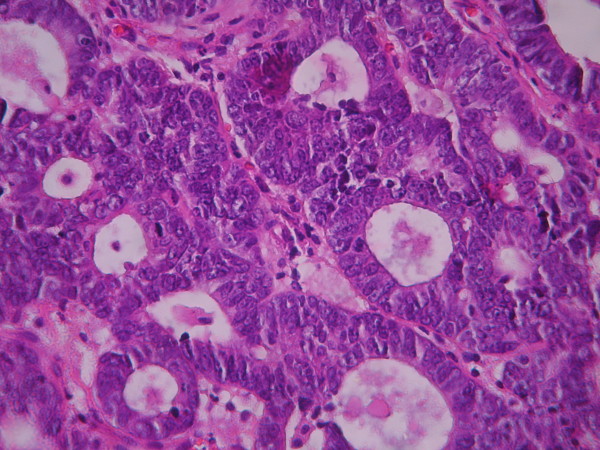
Endometrial adenocarcinoma. Confluent growth pattern of glands with no intervening endometrial stroma or loose granulation tissue like stroma. (High power).